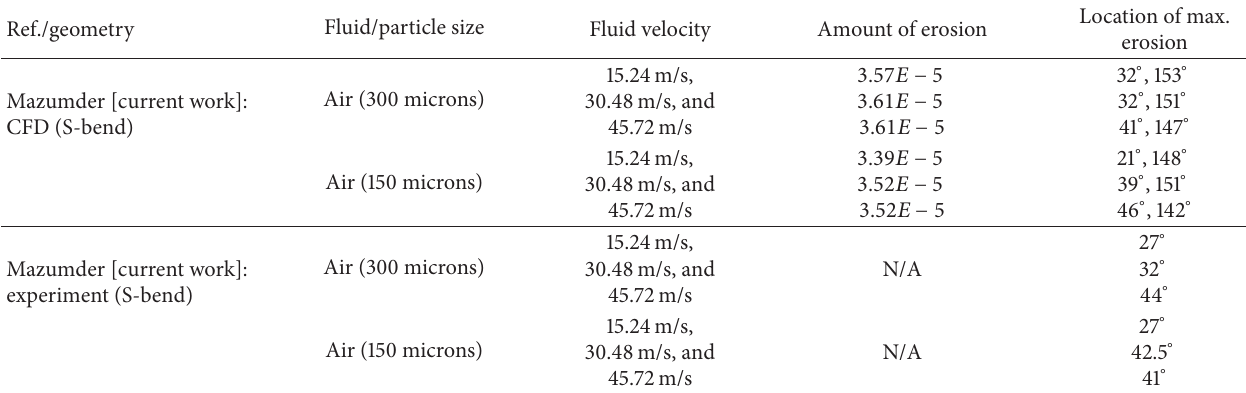
Table 3: Results of CFD and experimental